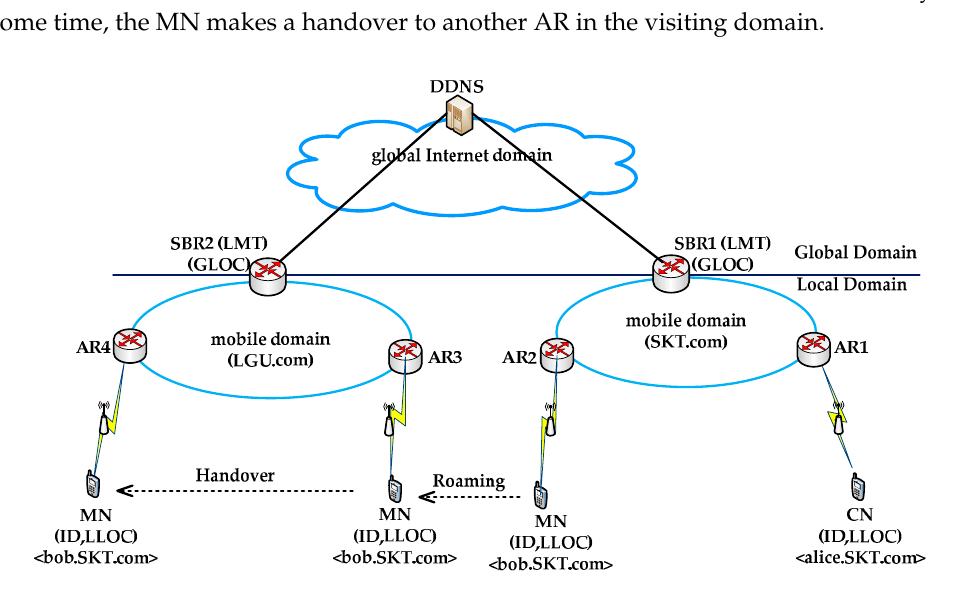
Figure 2. Identifier-locator (ID-LOC) management of ILNP-Global scheme.